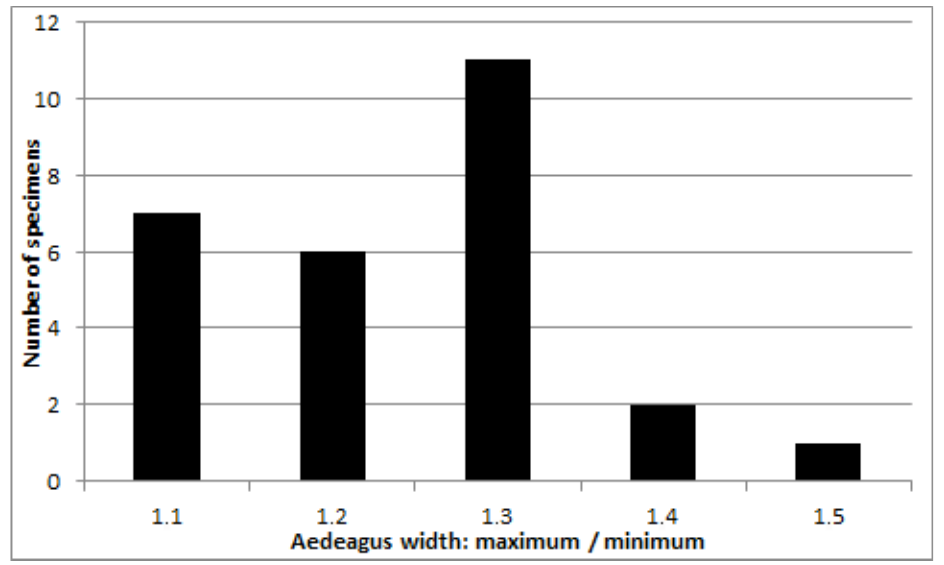
Figure 6. Chrysolina fascinatrix , male aedeagus, the ratio of the greatest width before apex to the smallest width at base. smallest width at